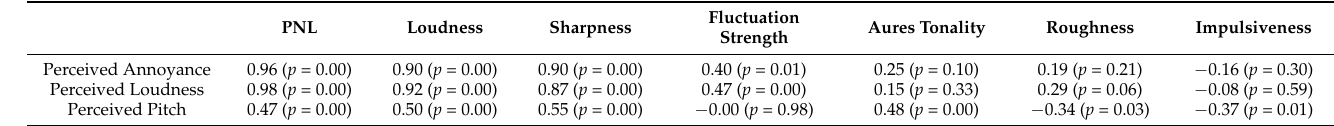
Table 7. Bivariate correlation coefficients (Pearson’s r coefficient) between PNL and the SQMs (loud- ness, sharpness, fluctuation strength, Aures tonality, roughness and impulsiveness) and perceived annoyance, loudness and pitch. p -value shown in